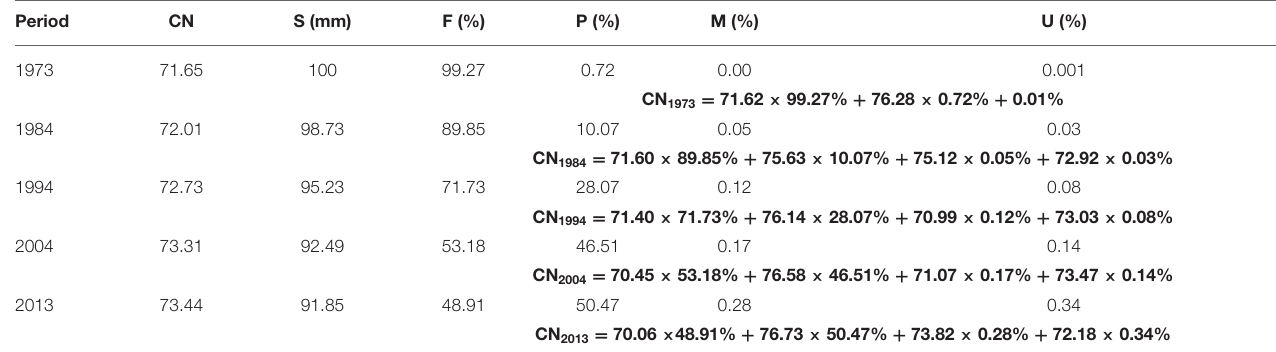
TABLE 2 | Evolution of totals (%) corresponding to land use and vegetation cover and the respective curve number and water storage calculated for the IRW over the decades.